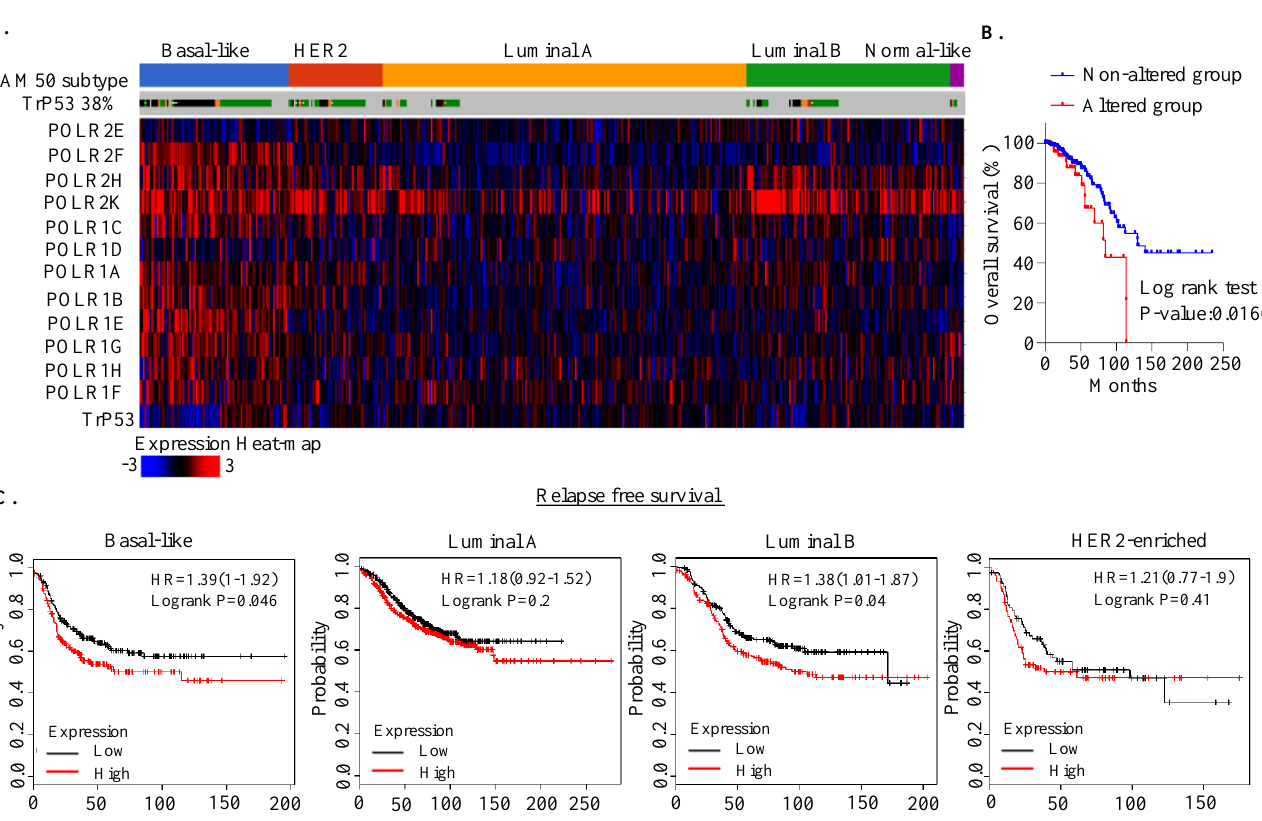
Figure 1. RNA polymerase I transcription alterations in breast cancer. ( A ) Heatmap analysis of components of RNA Pol I transcription at the mRNA level in TCGA breast cancer samples. Patient samples were subdivided into PAM50 subtypes. Data were derived from cbioportal (http://www.cbioportal.org/ (accessed on 1 March 2021)). ( B ) Breast cancer TCGA patient’ data were divided into two subgroups based on their expression patterns (whether altered or non-altered) and survival probability was plotted. ( C ) Kaplan–Meier survival analysis between components of RNA Pol I transcription alteration and clinical outcomes in breast cancer patients, using the KMplotter dataset (http://kmplot.com/ (accessed on 1 March 2021)). The expression pattern was stratified on relapse-free